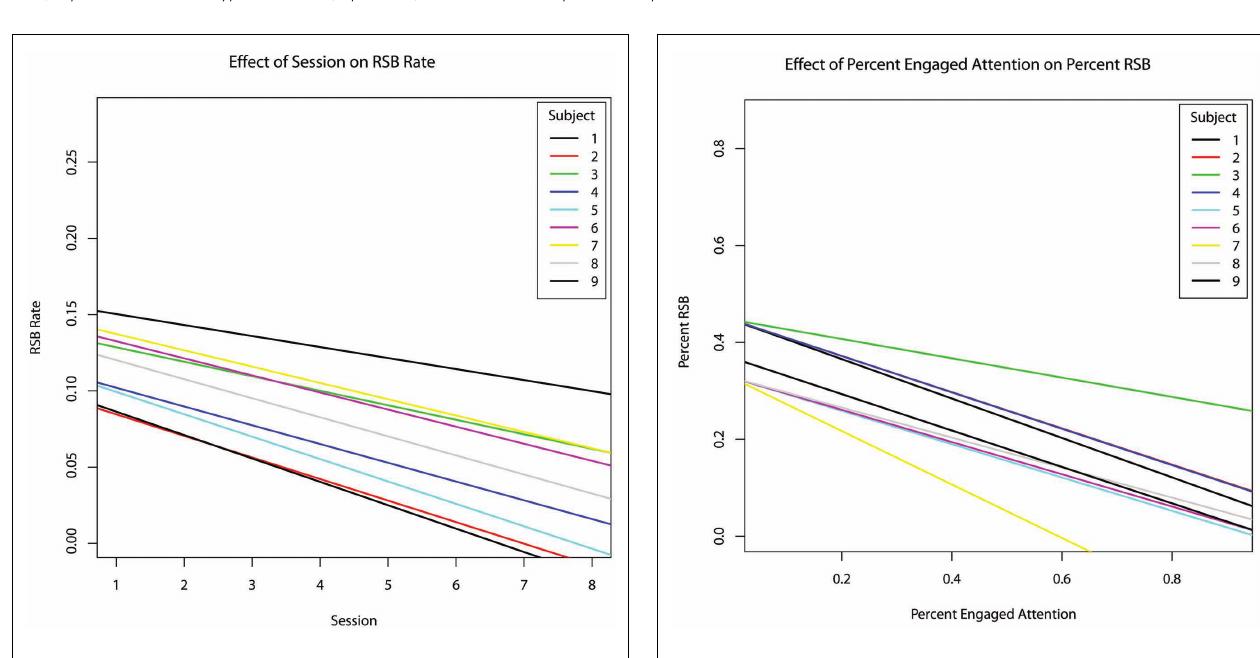
FIGURE 2 |The effect of fraction of time spent in overtly engaged attention within each session on the fraction of time spent in repetitive and stereotypic behaviours, controlling for